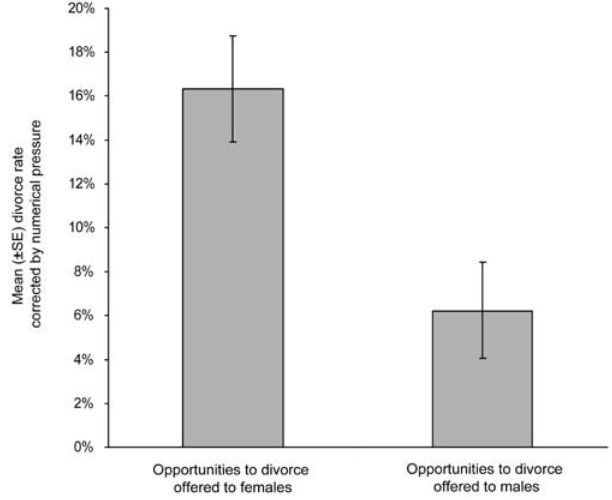
Figure 2. Differences in mean divorce rate corrected by numerical ‘pressure’ ( 6 SE), according to which sex is given opportunities to divorce. The numerical ‘pressure’ is measured as the number of individuals introduced during the second infection divided by the number of individual of the same sex introduced on the first